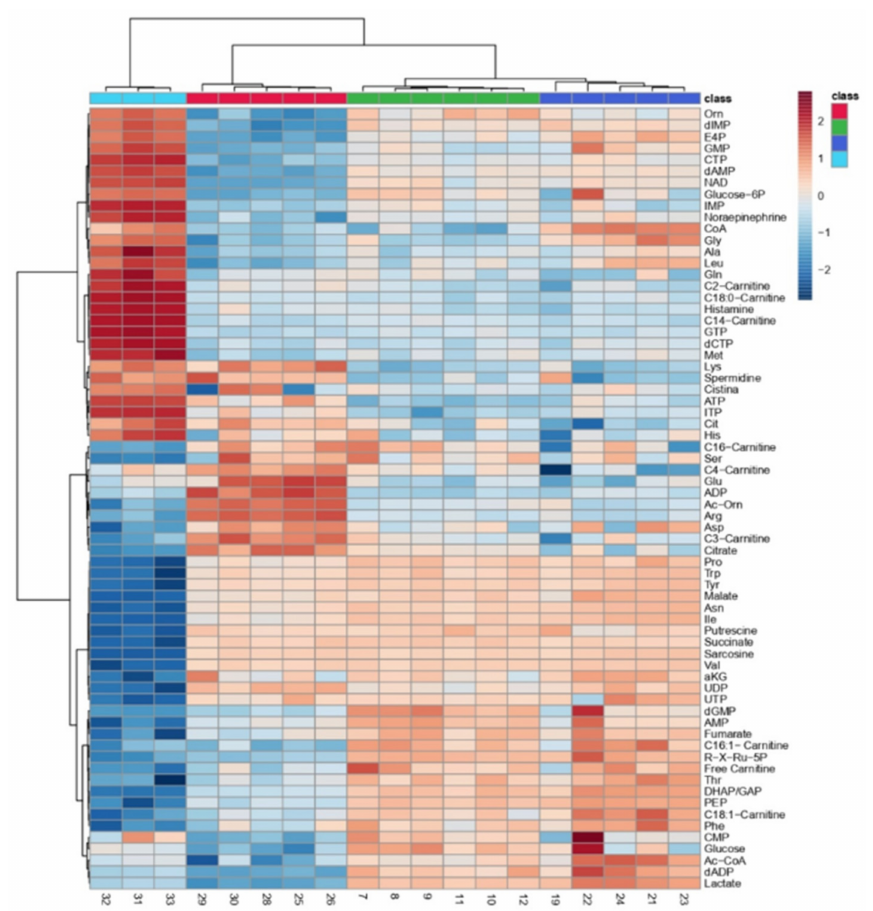
Figure 7. Heatmap of metabolites detected by mass spectrometry in iPSCs and dopaminergic neurons at days 24, 45 and 60 of